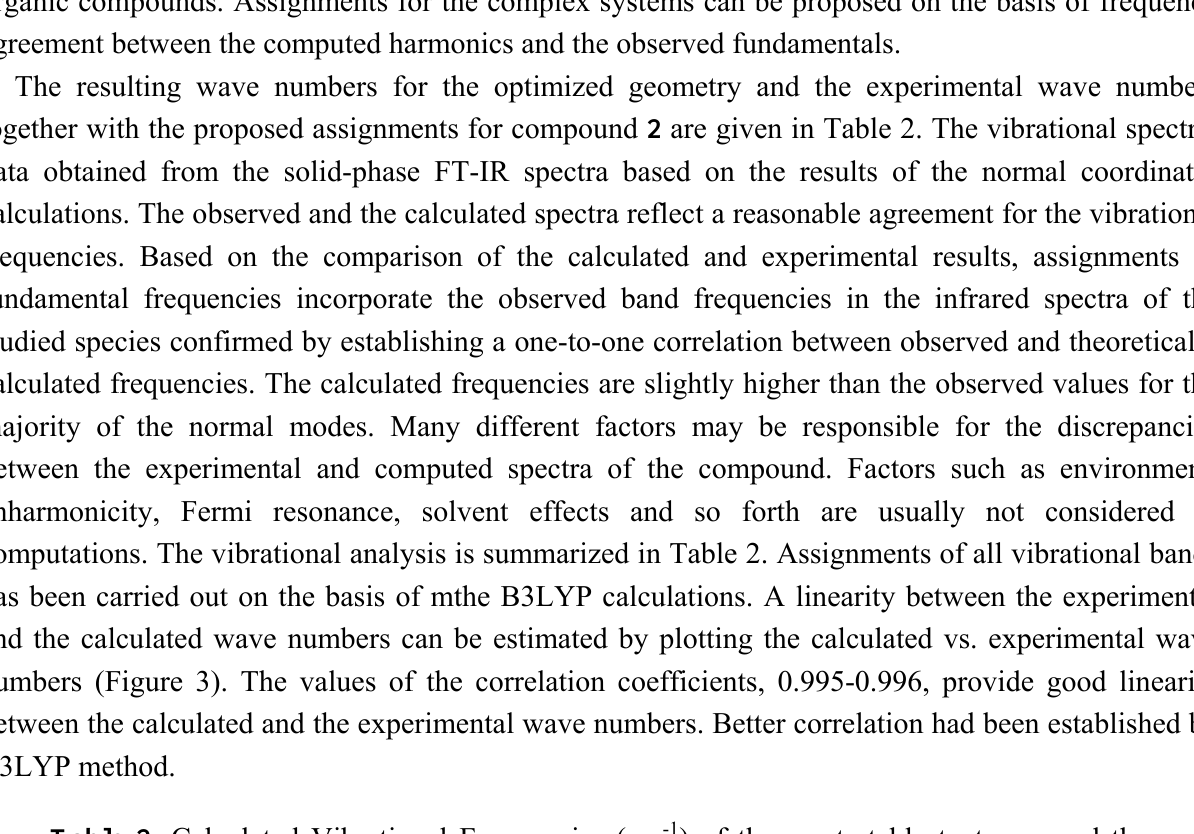
Table 2. Calculated Vibrational Frequencies (cm -1 ) of the most stable tautomer and the observed frequencies of compound 2